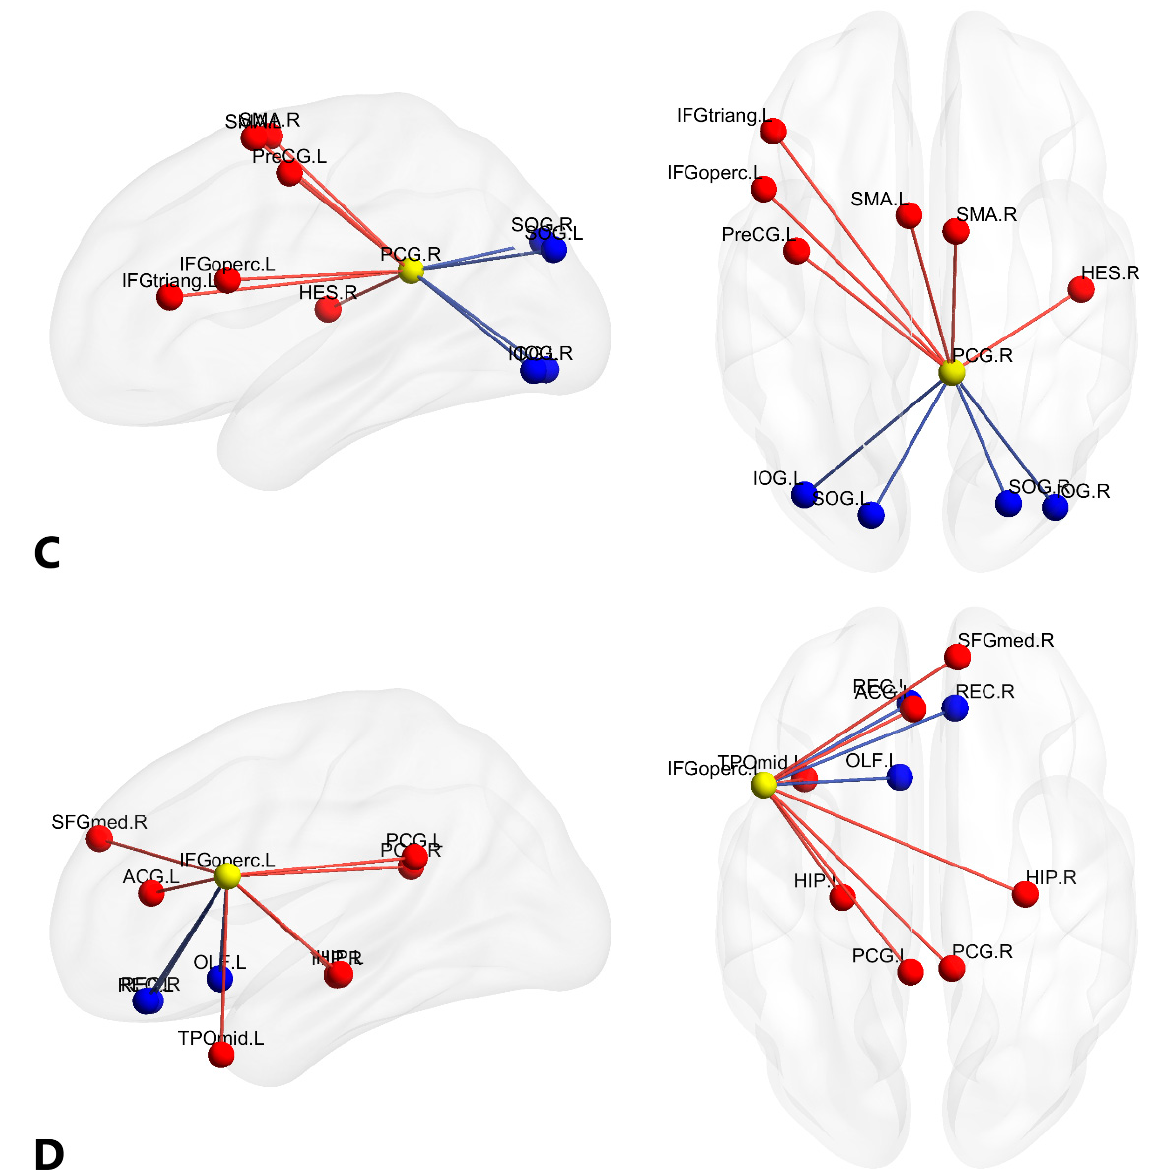
Figure 2. Visualization of selected nodes with the highest sum of edges in both the BG and MG subnetworks. In each figure, the selected node is shown in yellow (see Table 1 for the coordinates of selected nodes), while nodes more strongly connected to the selected node in the bilinguals (BG) > monolinguals (MG) (i.e., BG) network are shown in red, and nodes more strongly connected to the selected node in the MG > BG (i.e., MG) network are shown in blue (see Table S2 for the coordinates of all MG and BG partner nodes). Red and blue lines simply schematize connectivity between the selected node and each of its functional partners. ( A ) Connectivity between the right inferior parietal lobule (IPL) and all MG and BG partner nodes; ( B ) connectivity between the right postcentral gyrus (PoCG) and all MG and BG partner nodes; ( C ) connectivity between the right posterior cingulate gyrus (PCG) and all MG and BG partner nodes; ( D ) connectivity between the left inferior frontal opercular part (IFGoperc) and all MG and BG partner nodes. Note that all figures are shown in neurological convention (subject’s left is image’s left), and axial views are top-down.